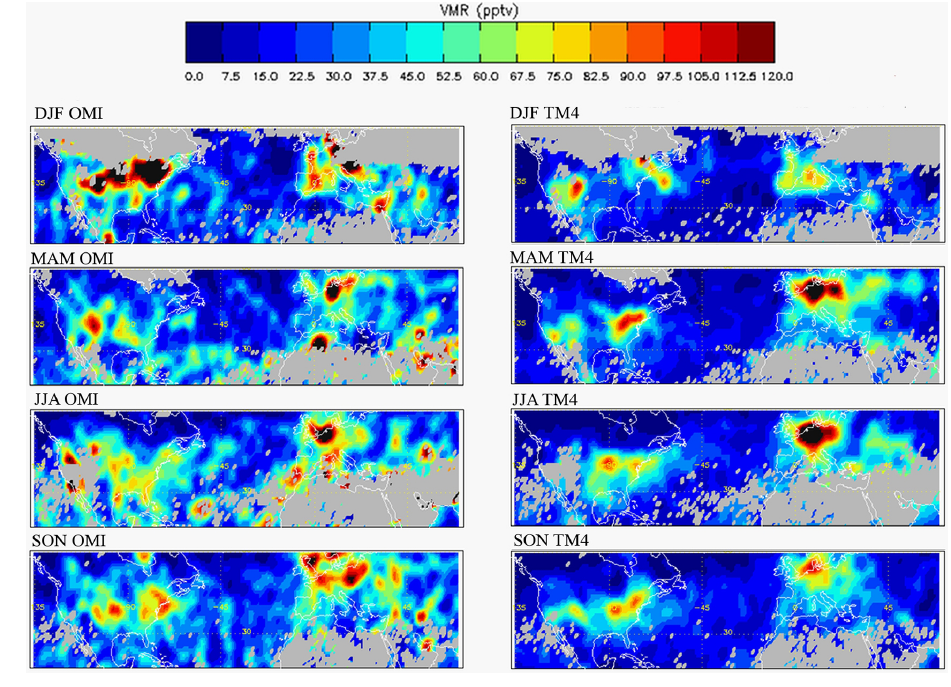
Figure 31. Same as Fig. 29 but at 620hPa.